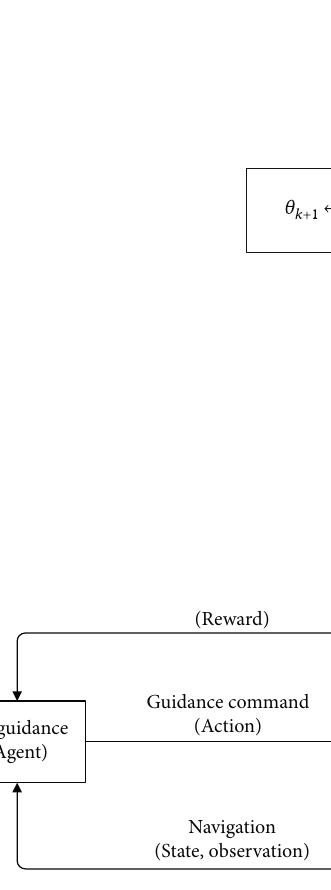
Figure 2: Guidance-based RL